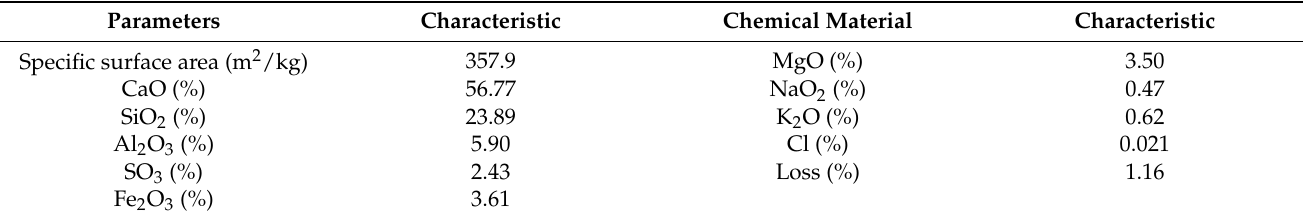
Table 2. Parameters of the P.O. 52.5 Portland